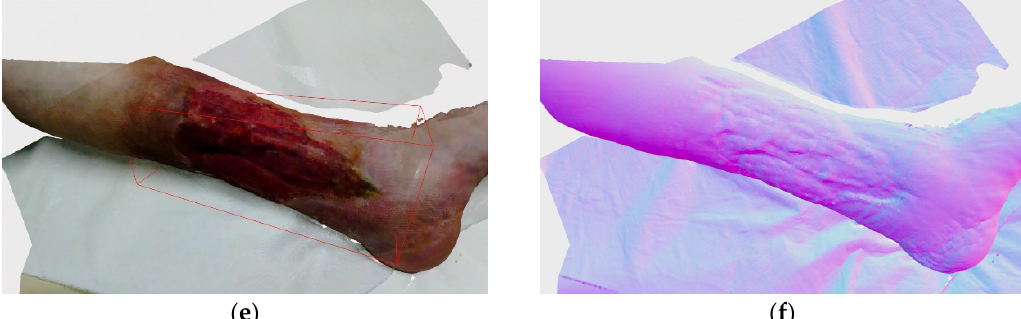
Figure 18. Hospital Recording of venous ulcer 2; ( a ) wound detection at initial recording position, ( b ) recording poses relative to the recorded wound, ( c ) robot position in relation to the recorded wound in first recording, ( d ) robot position in relation to the recorded wound in second recording, ( e ) final reconstructed 3D model, ( f ) final reconstructed 3D model with normal map rendering.